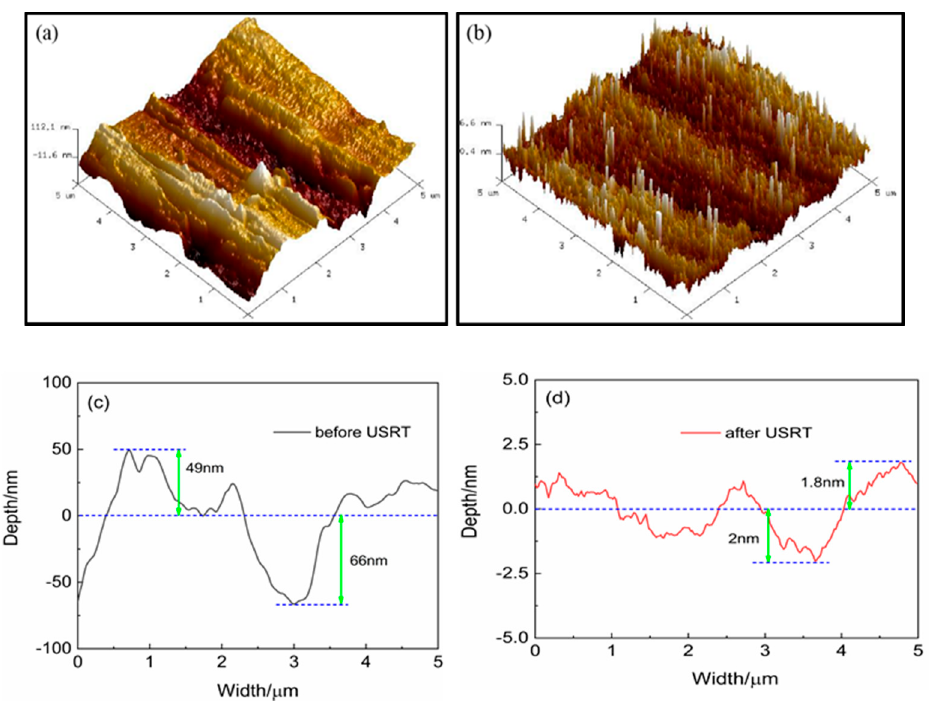
Figure 2. Surface topography of alloy 690 ( a , b ) 3D and ( c , d ) 2D ( a , c ) before and ( b , d ) after ultrasonic surface rolling treatment (USRT).